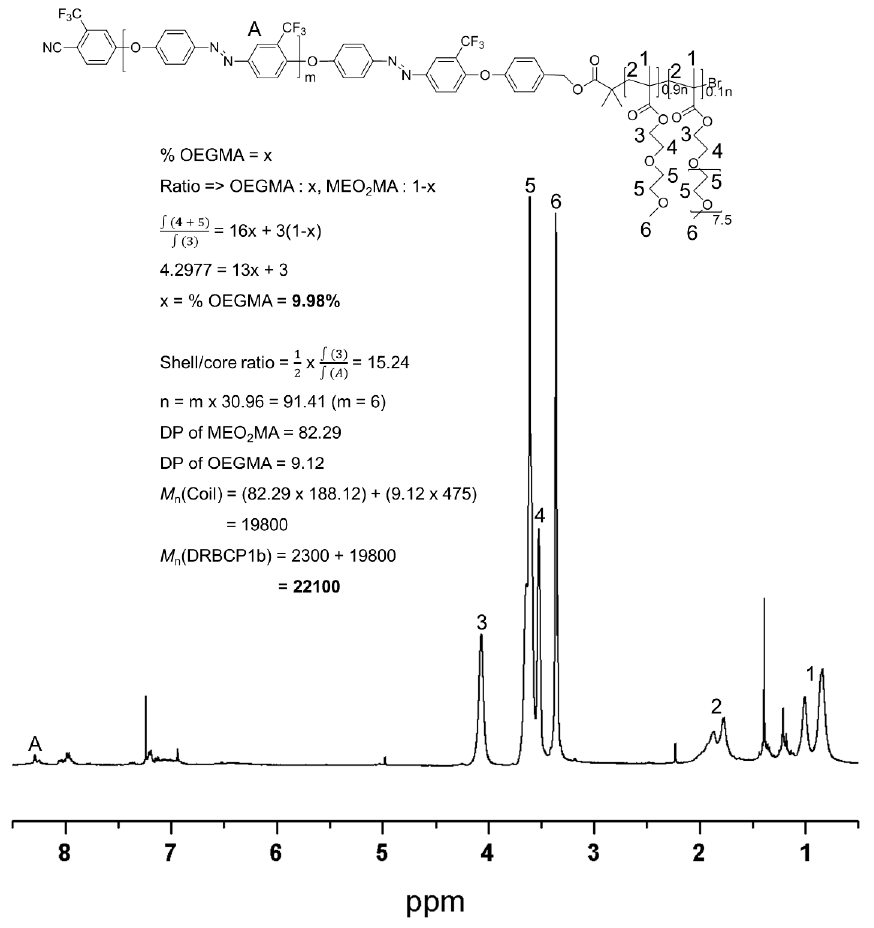
Figure 2. 1 H-NMR spectrum with calculation of % OEGMA and molecular weight of DRBCP1b in chloroform- d .